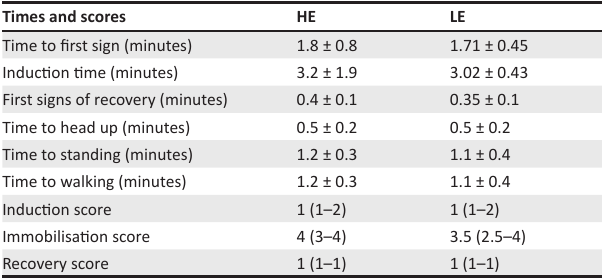
TABLE 2: Mean ± standard deviation of induction and recovery times and median score (range) of quality of induction, immobilisation and recovery of 12 female blesbok administered two etorphine–azaperone combinations characterised by different etorphine dose. † Times and